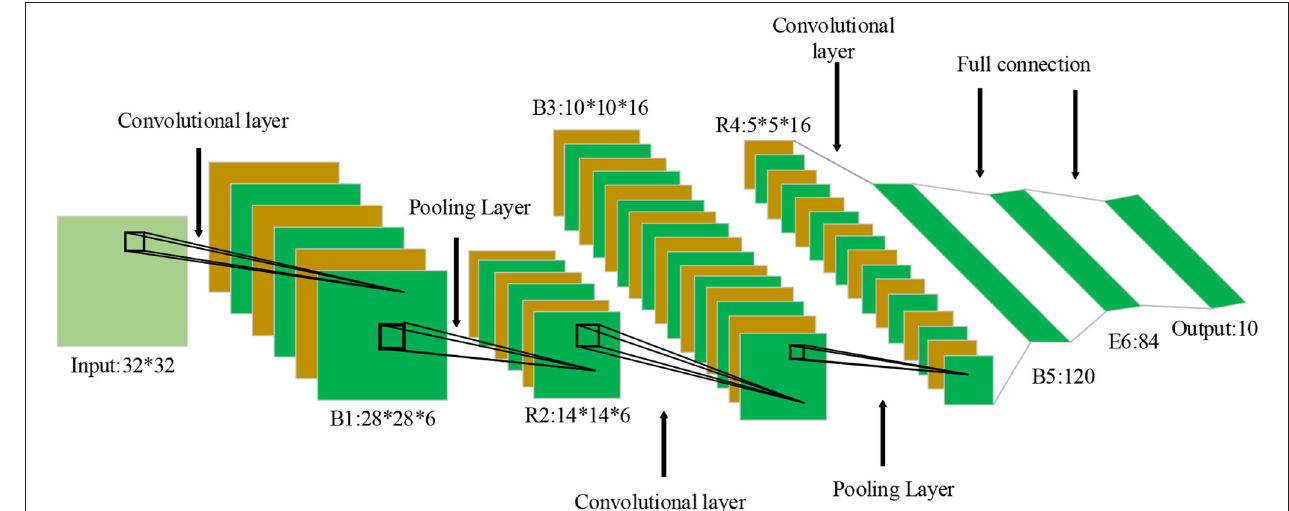
FIGURE 2 | Convolutional neural network (CNN) structure. *Indicates the size of different connection layers of neural network.